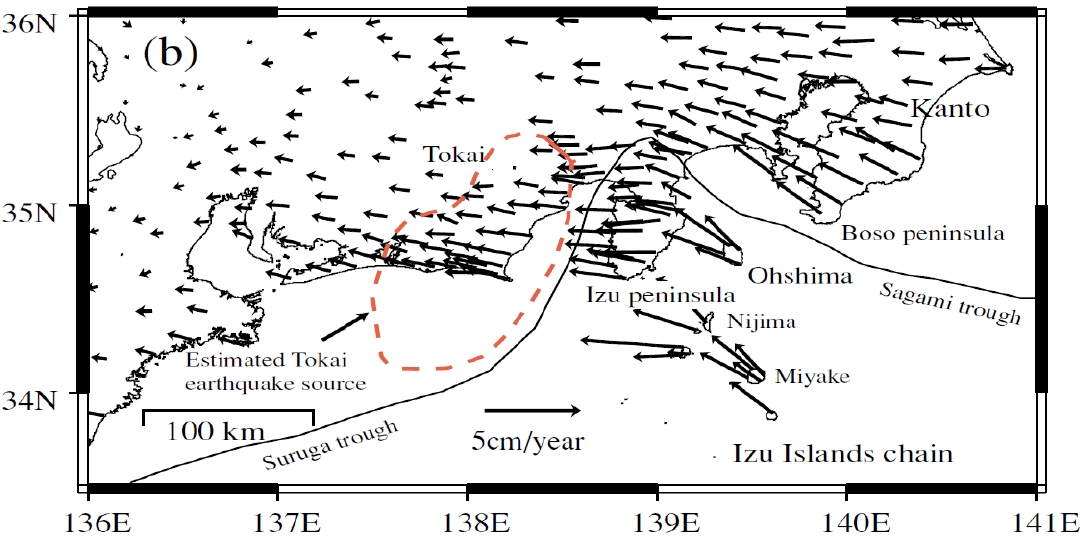
Figure 10. Horizontal deformations in Tokai area, measured by GPS. The Philippine sea plate subducts beneath the continental plate from the Suruga and Sagami troughs. The black arrow represents the observed ground displacement rate in cm/year for the period between 1997 and 1999. Stroke line represents the estimated source area of the expected Tokai earthquake